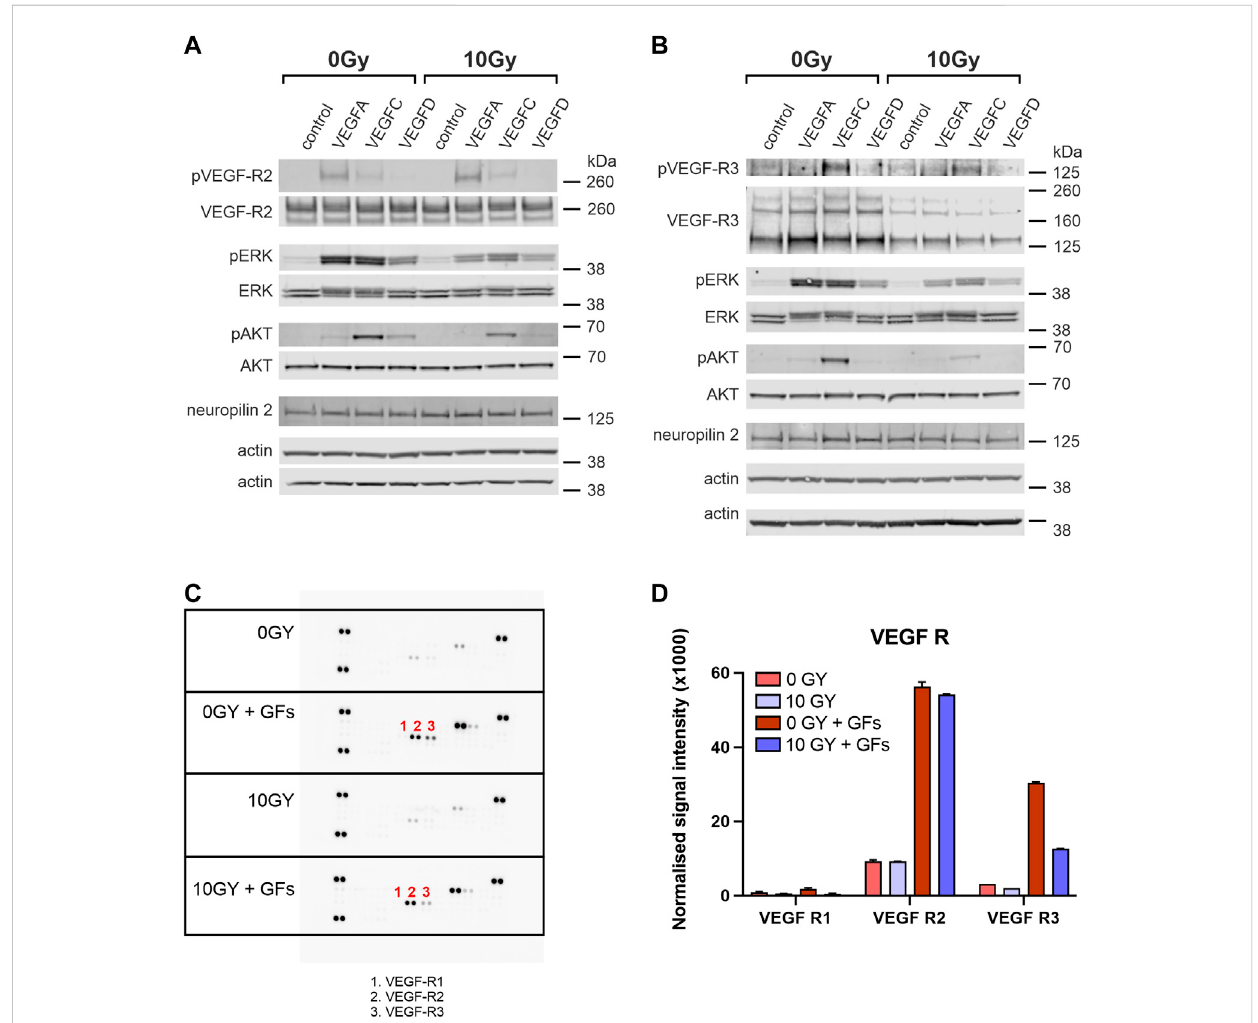
VEGFR-2 and VEGFR-3 activities are differentially altered with radiation treatment. Western blot analysis of cell lysates comparing levels of phosphorylated and total VEGFR-2 (A) and VEGFR-3 (B) in untreated (0 Gy) and irradiated (10 Gy) LEC stimulated with VEGF-A, VEGF-C or VEGF-D. Unstimulated cells served as a baseline control and VEGF-A is used as a control for VEGFR-2. The phosphorylation status of downstream signalling moleculesERKandAKT,aswellasthelevelsofneuropilin2(aVEGFR-3co-receptor)andb-actin(loadingcontrol),arealsoshown. (C) Phospho-RTK antibody arrays were used to compare RTK activation in untreated and irradiated LEC. The identity of relevant phosphorylated RTKs is indicated by number: 1- VEGFR-1, 2 - VEGFR-2 and 3 - VEGFR-3. (D) The graph quanti fi es the normalized signal intensity and demonstrates an ameliorated VEGFR-3 signallingresponseinirradiatedLECcomparedtounirradiatedcontrols,whenstimulatedwithgrowthfactors.WesternBlotassaysperformedaminimum of 3 times, RTK assays were performed with 1 biological and 2 technical replicates. Data expressed as mean with error bars represented as SEM.